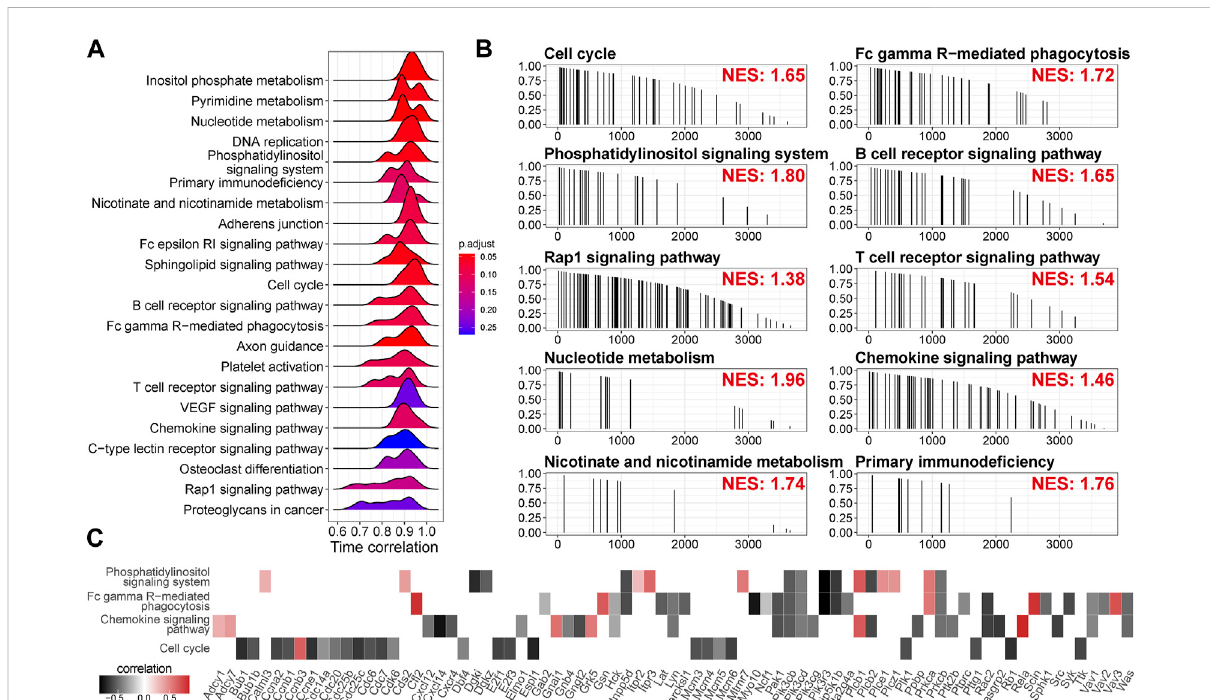
FIGURE 6 Time-related signaling pathways are related to metabolism, cell cycle, and immune response. (A) Time correlation distributions of genes in the individual pathways. The height of peaks indicates the number of the enriched genes. p -value is adjusted by Benjamini and Hochberg method. (B) Mappingofthegenesintheindividualpathwaysalongthedescendingtimecorrelationrank.NES,enrichmentscorenormalizedtomeanenrichment ofrandomsamplesofthesamesize,estimated bygenesetenrichmentanalysis(GSEA). (C) Timecorrelationofthegenesintheleading edgeof